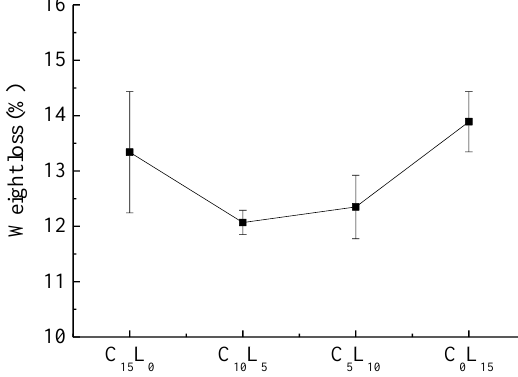
Figure 5. Wear performance of the brake composites.